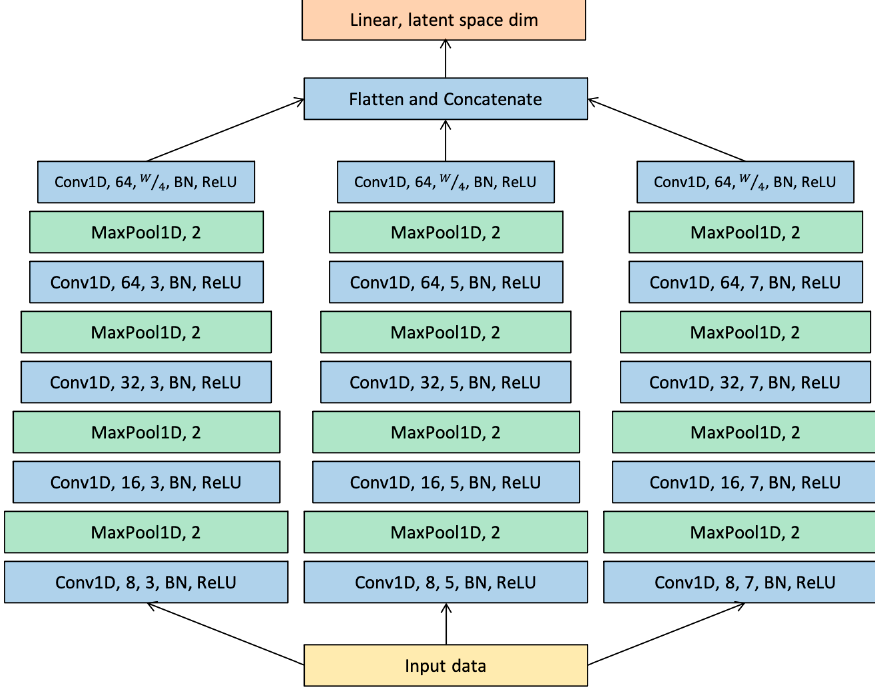
Figure A1. Exact architecture of the